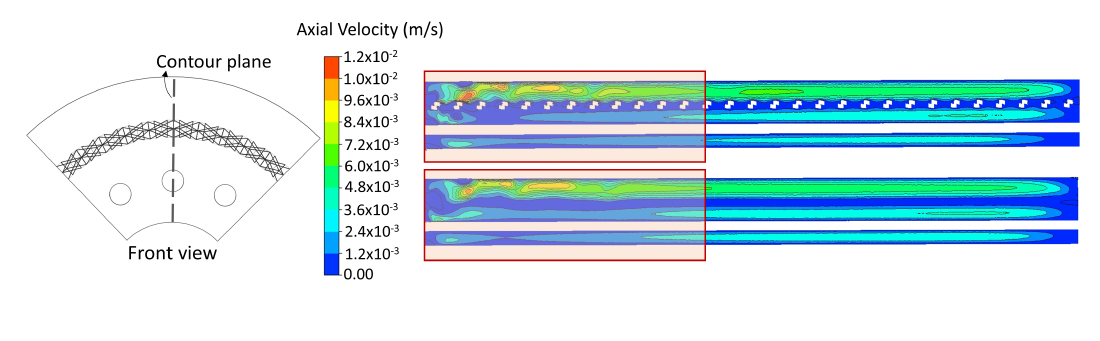
Figure 16. Axial velocity contours using the RGB and PM